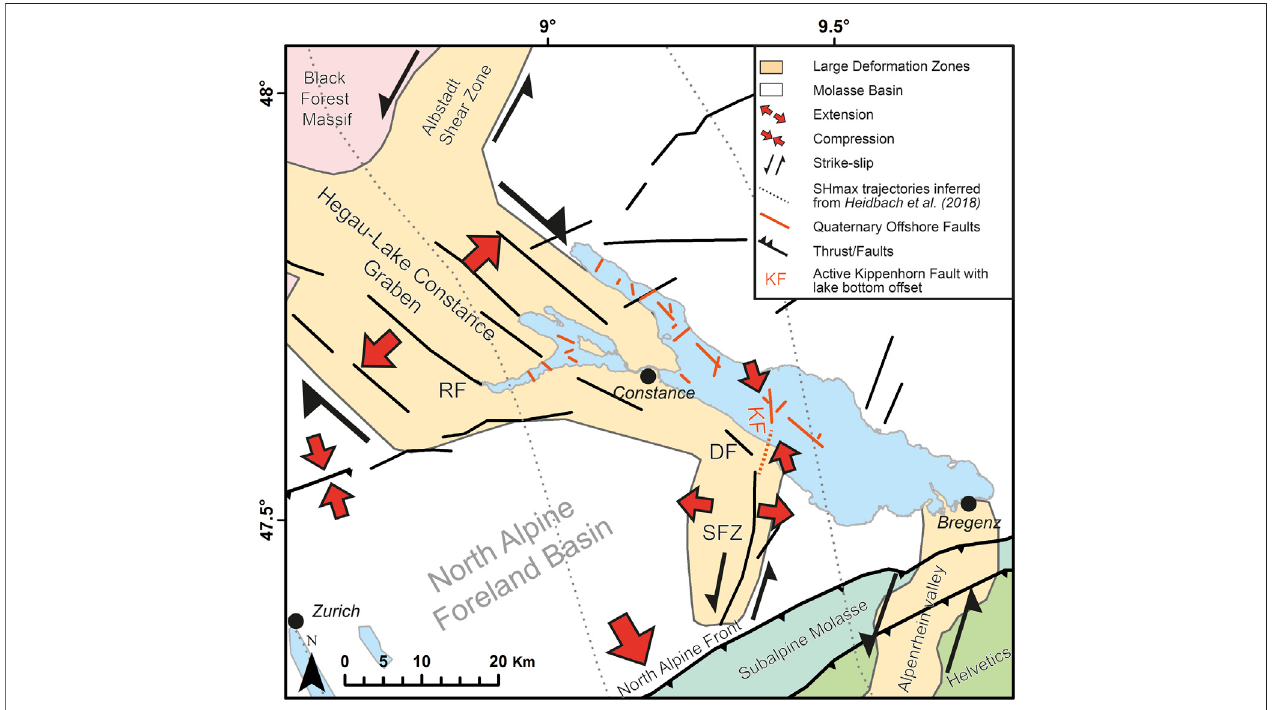
FIGURE 14 | Close-up of Figure 2 additionally showing the newly identi fi ed active faults (simpli fi ed) in Lake Constance. Estimated maximum horizontal stress (SHmax) trajectories are inferred from Heidbach et al. (2018). DF: Dozwil Fault, RF: Randen Fault, SFZ: St. Gallen Fault Zone (also see Supplementary Table S1 ). The Kippenhorn Fault (KF) lies in the prolongation of the SFZ, both ideally oriented for reactivation in locally NNW-SSE striking SHmax. Quaternary offshore faults are summarized and simpli fi ed (see Figures 10 , 11 for details).